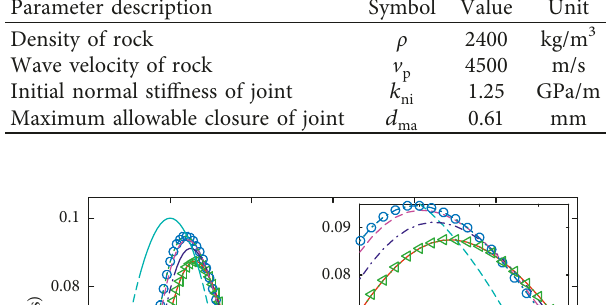
Table 2: Joint closure d n corresponding to the amplitude of the transmitted wave based on the g - λ model.